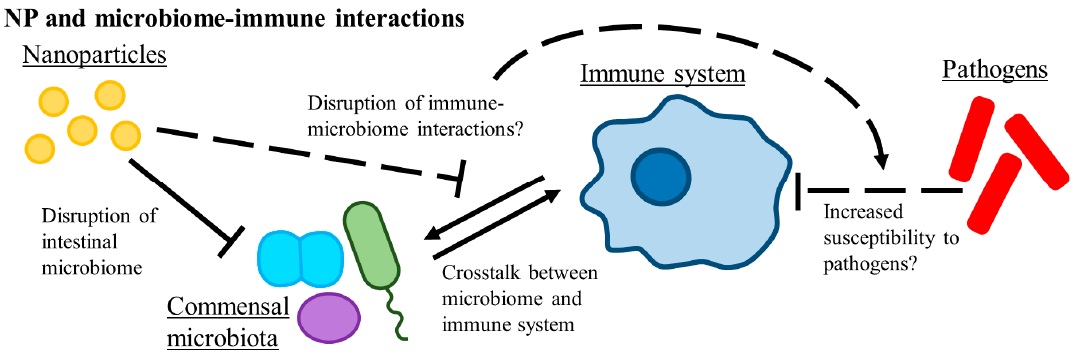
Figure 3. Potential disruption of host microbiota by NPs could lead to altered host immune responses and increased pathogen susceptibility. Solid arrows indicate interactions that are well described in literature. Dashed arrows indicate understudied interactions and possible future focal points for NP research.